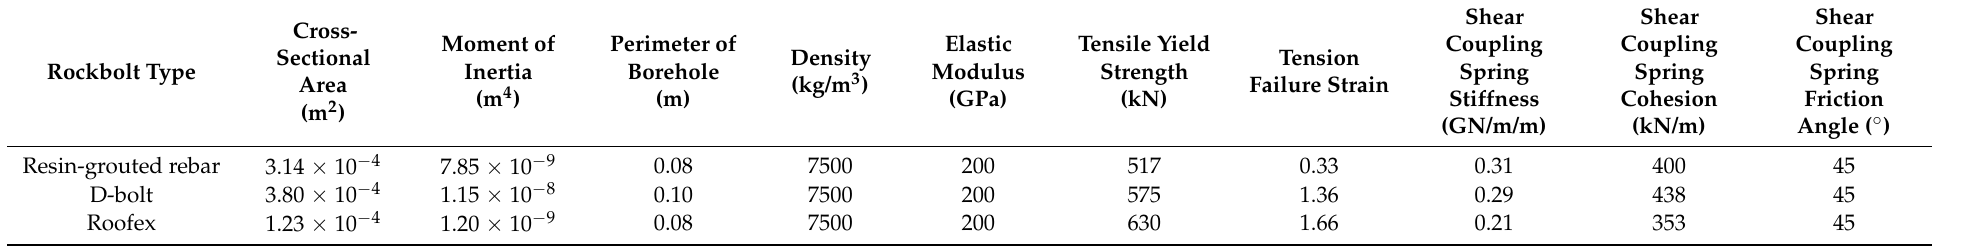
Table 5. Calibrated input parameters of rockbolts.